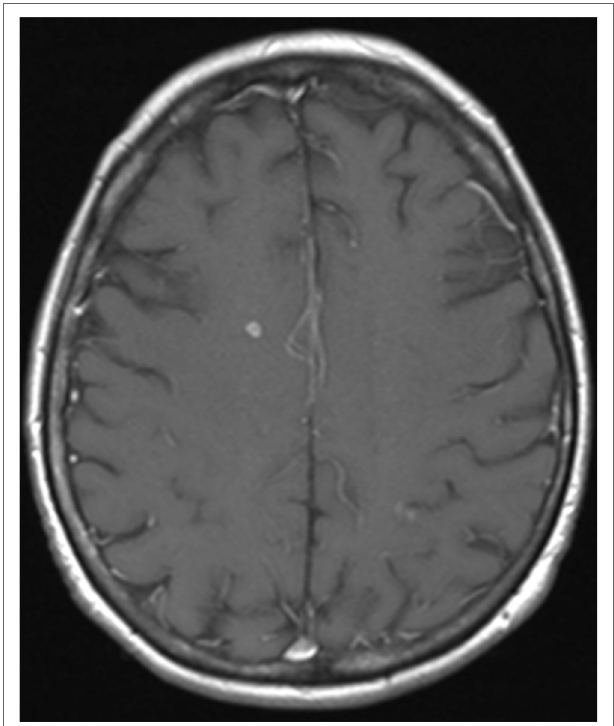
FIGURe 3 | Brain magnestic resonance imaging in March 2014. T1-weighted image after gadolinium of the brain shows a small right frontal enhancing cerebral